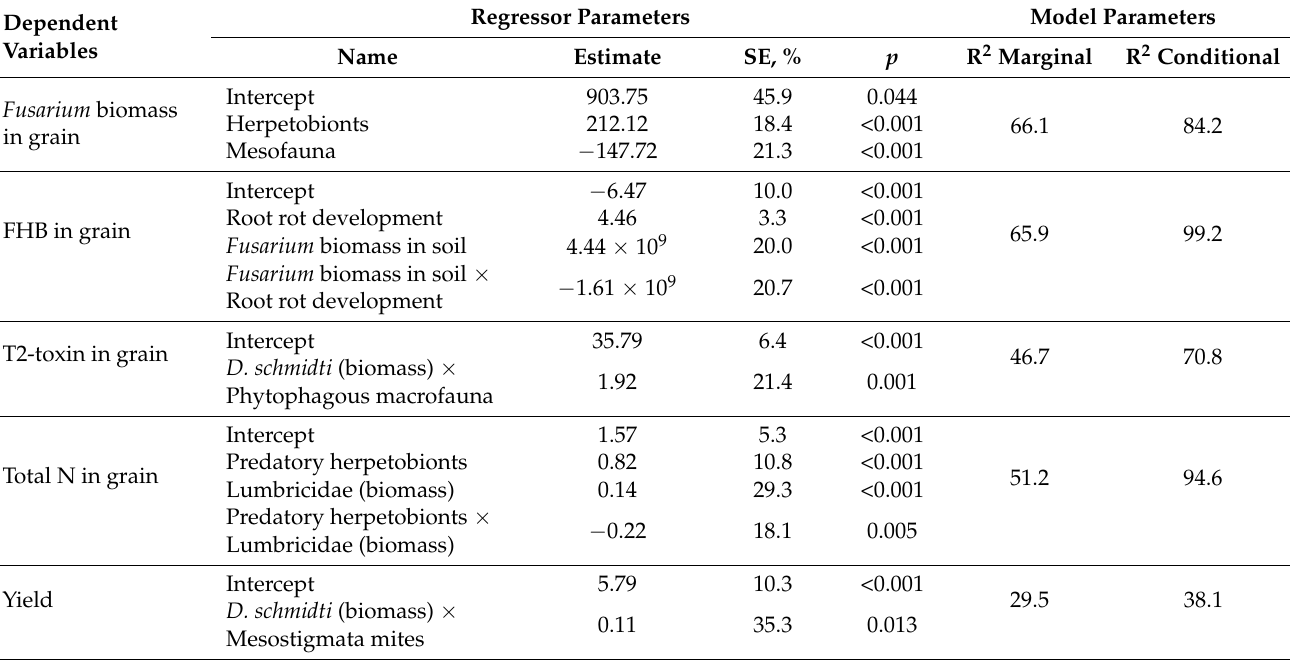
Table 4. Coefficient values of regressors and information statistics of optimal models for the five FHB related study endpoints. R 2 marginal–proportion of variability observed in the whole data sample explained by fixed effects only. R 2 conditional proportion of variability observed in the whole data sample explained by fixed effects and random